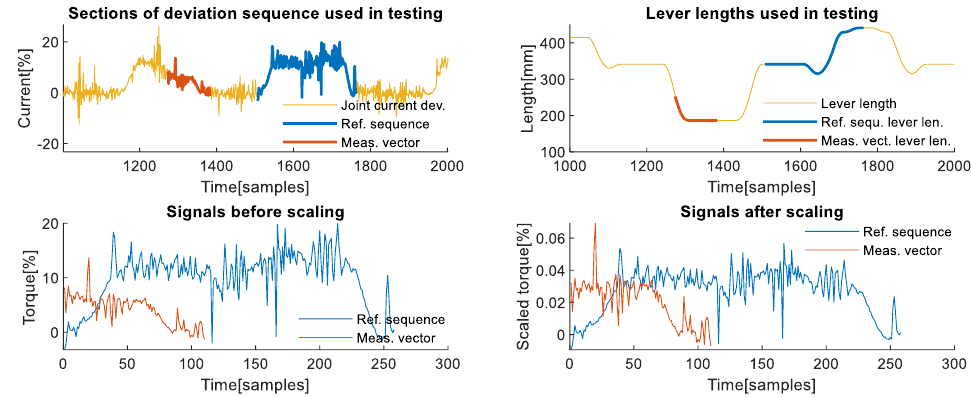
Figure 4. Signals used in the analysis for the 2nd axis. ( Upper left ) Sections of the deviation signal are used as a reference sequence and as a measurement vector during analysis. ( Upper right ) Highlighted sections of the lever lengths corresponds to the chosen reference sequence and chosen measurement vector. ( Lower left ) Original values of signals used as reference sequence and measurement vector shown prior to scaling by the algorithm. ( Lower right ) Signals used as reference sequence and measurement vector after scaling was performed.